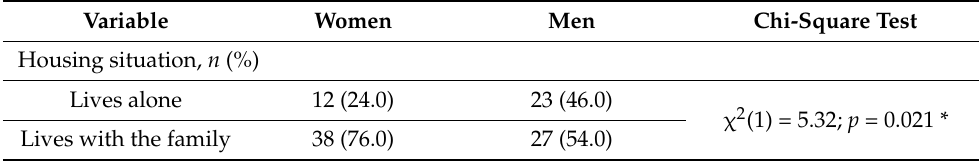
Table 1. Housing situation of the participants. Variable Women Men Chi-Square Test Housing situation, n (%) Lives alone